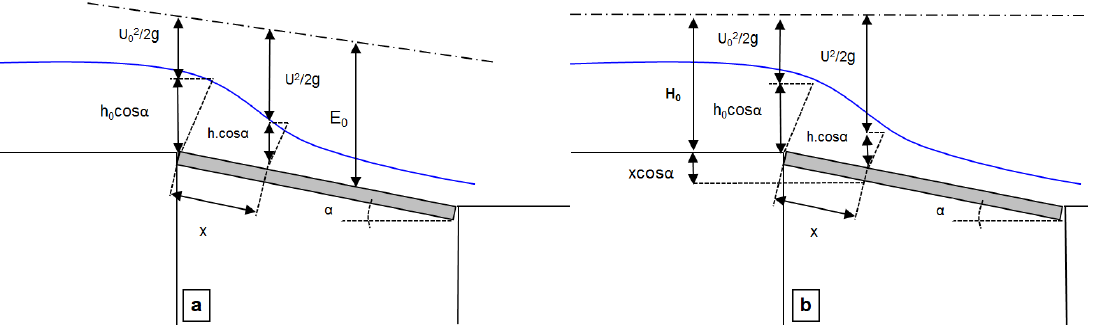
Figure 2. Scheme of longitudinal flow profile over the bottom racks for constant specific energy head ( a ) or constant energy level ( b ).